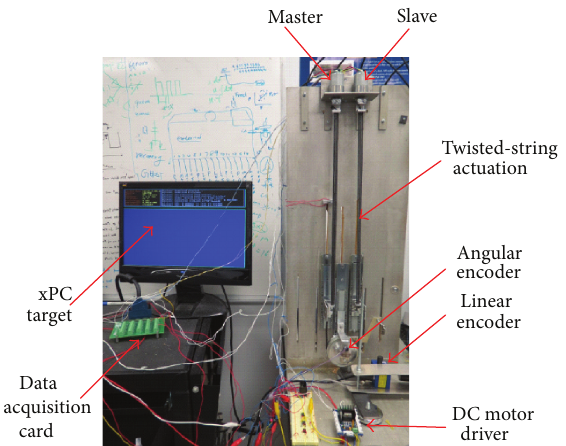
Figure 4: Configuration of experimental setup of a dual twisted- string actuation